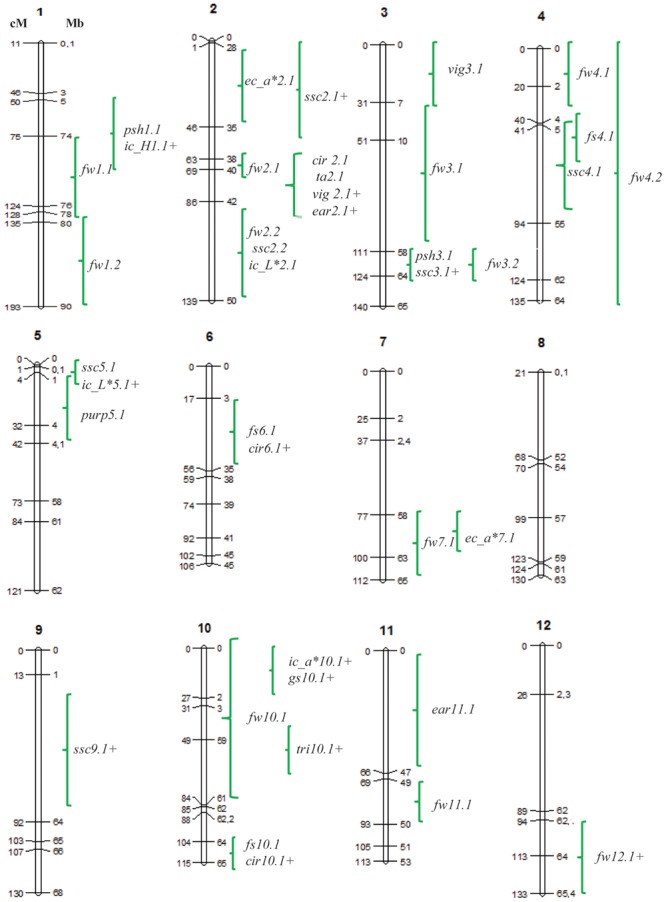
Quantitative trait loci (QTL) positions on the tomato map. Genetic distances (cM) are shown on the left of the chromosome drawings, and physical distances (Mb), according to the tomato genome version SL2.40, on the right. QTLs are named using an abbreviation of the trait: plant vigour (VIG), earliness (EA), presence or absence of anthocyanin coloration in branches and stems (PURP); trichome density (TRI), green shoulder on the fruit (GS), FW, FS, circular shape (CIR), shoulder height (PSH), soluble solid content (SSC), TA and internal and EC (ICOL, ECOL, respectively) based on CIELab color system variables a∗, b∗, L∗, H, C∗, followed by the chromosome on which they map and a digit indicating the number of the QTL within the chromosome. (∗) Indicates that the TO-937 wild allele increases the trait value.